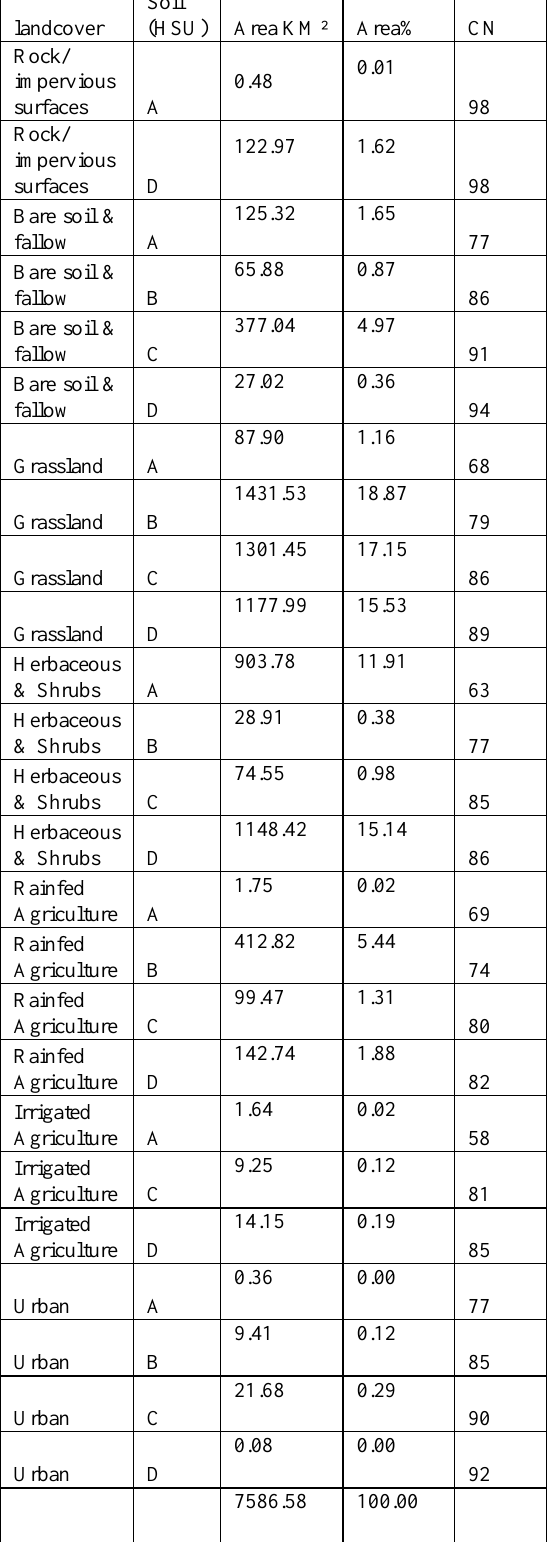
Table 2. Wadi El Hawad catchment lancover units, hydrologic soil groups (HSG), CN values and area%